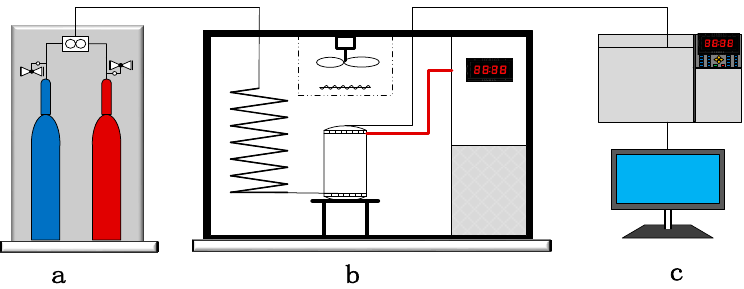
Figure 1. Temperature-programmed system: ( a ) air supply system; ( b ) temperature-programmed reaction system; ( c ) gas concentration detection system.